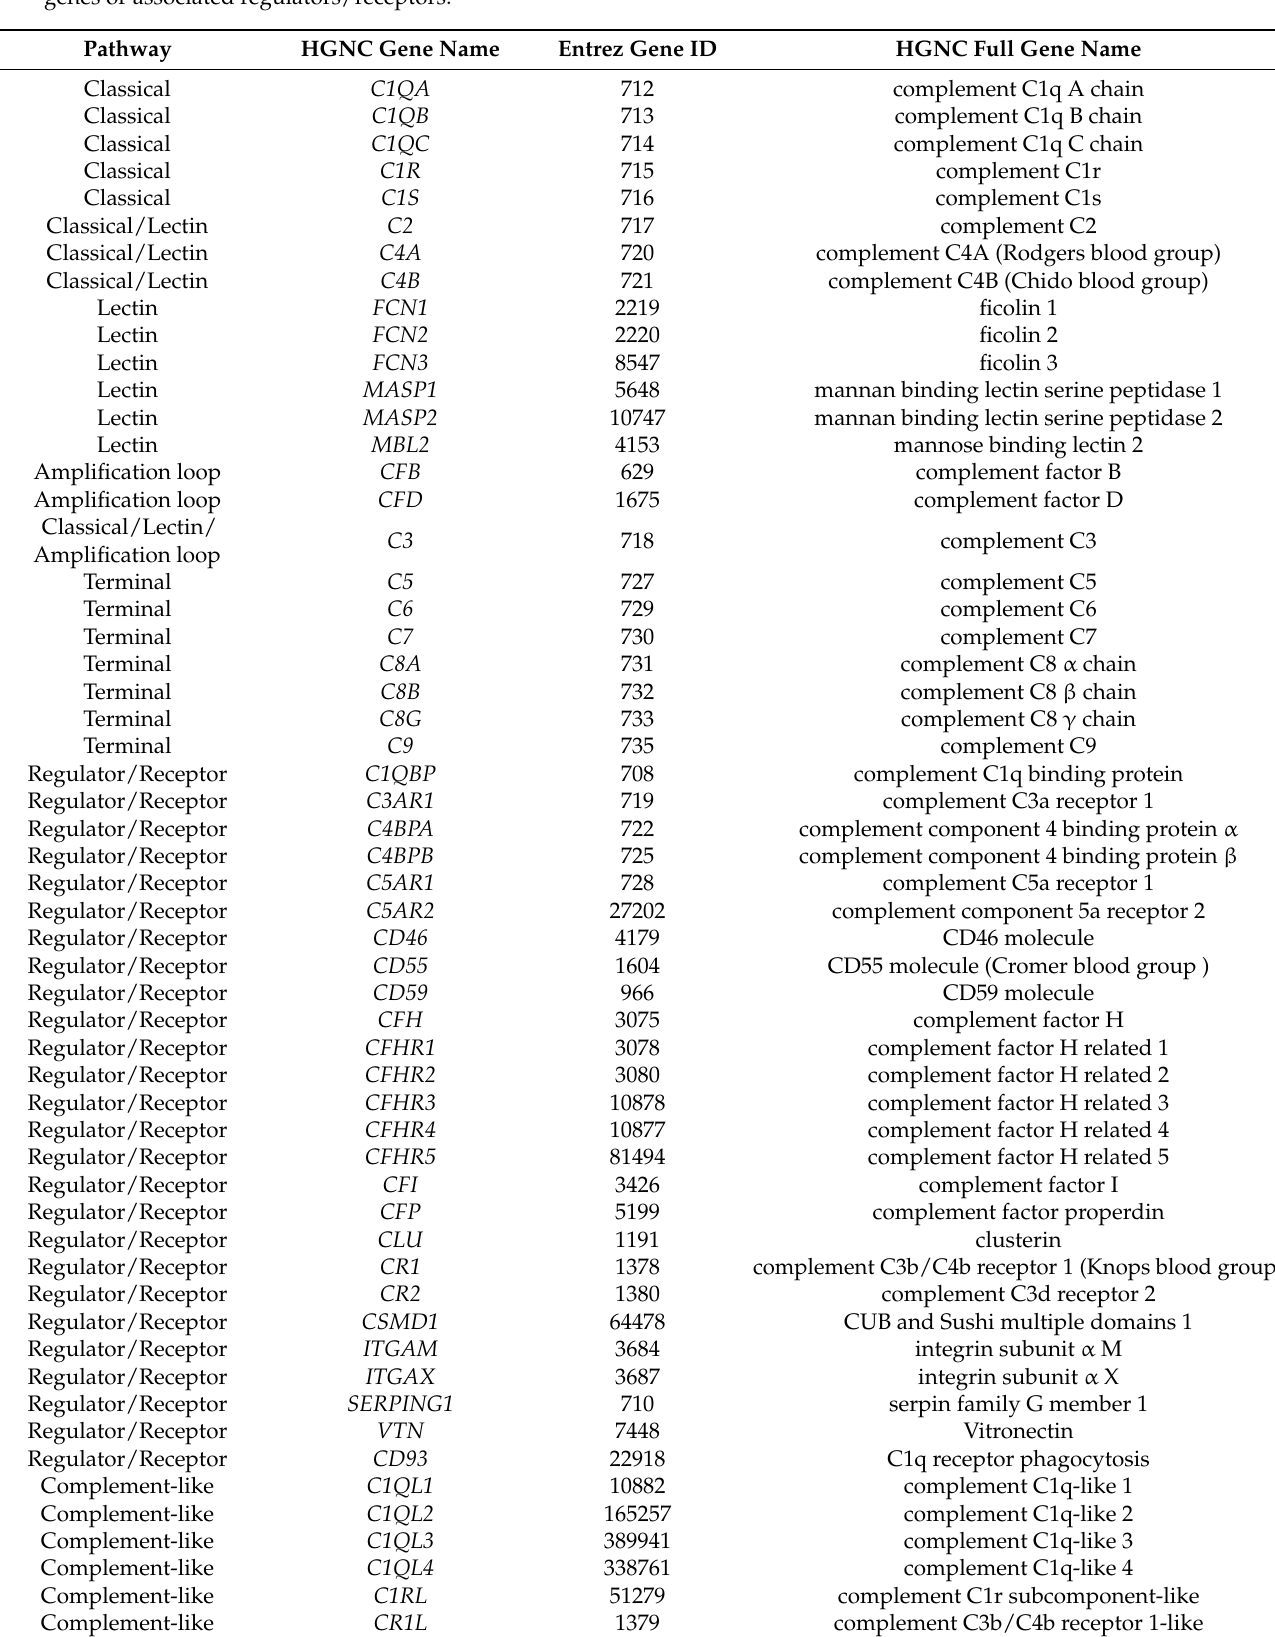
Table 1. Complement gene list including all complement genes and associated regulators and receptors. Genes are sub- divided according to pathway; either classical, lectin, amplification loop or terminal and whether they are complement genes or associated